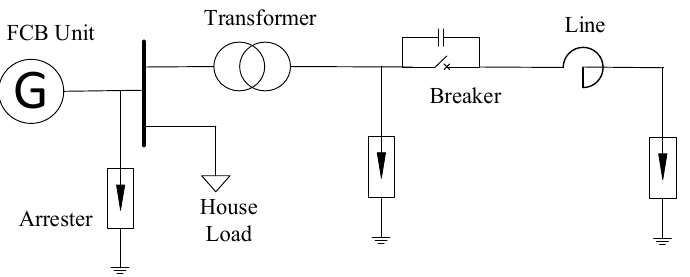
Figure 14. Model structure